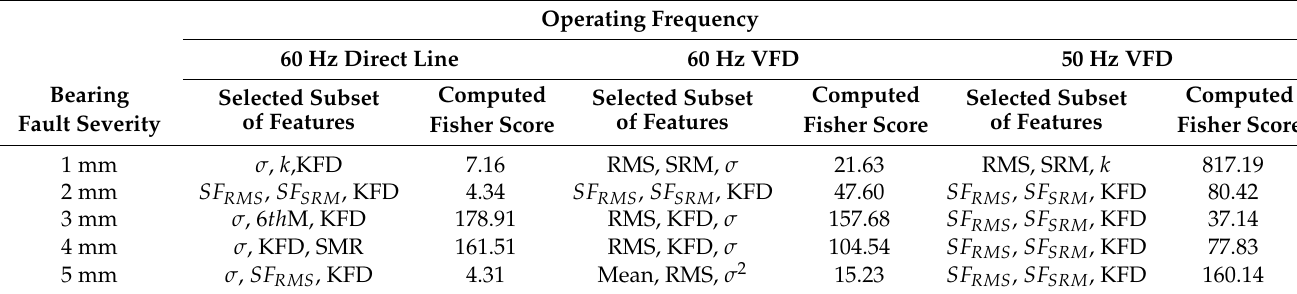
Table 3. Detail of the selected subsets integrated by considering combinations of three statistical time features in the Fisher score analysis for a power supply frequency of 60 Hz, and 50 Hz.